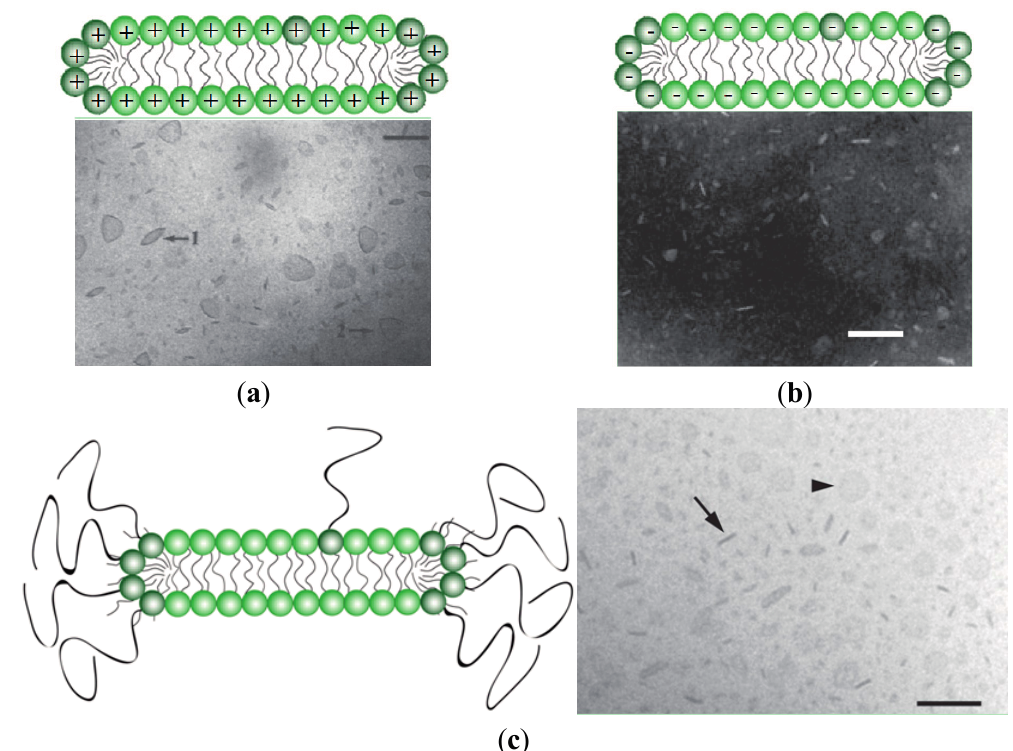
Figure 5. ( a ) Cationic bilayer disks of DODAB from cryo-transmission electron microscopy (cryo-TEM). The bar corresponds to 100 nm. Adapted from [213] with permission from 1995 American Chemical Society; ( b ) Anionic bilayer disks of sodium dihexadecylphosphate (DHP) from negatively stained dispersions seen by TEM. The bar corresponds to 100 nm. Adapted from [214] with permission from 1991 American Chemical Society; ( c ) Neutral phospholipid disks of POPC/Chol/ceramide-PEG5000 (35:40:25 mol %) from cryo-TEM. The bar corresponds to 100 nm. The arrow and arrowhead indicate disks observed edge-on and face-on, respectively. The bar corresponds to 100 nm. Reprinted from [203] with permission from Elsevier, Copyright